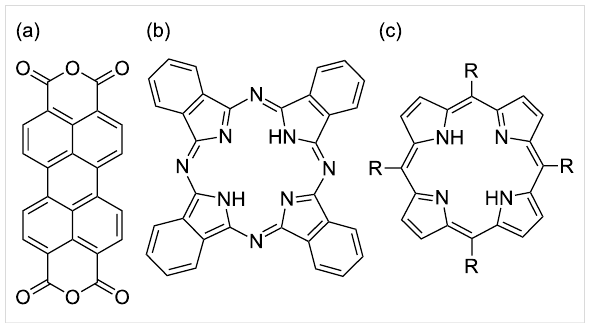
Figure 1: The discussed molecular species (a) PTCDA, (b) metal-free phthalocyanine (H 2 Pc), in which the central hydrogen atoms may be substituted by a metal atom, e.g., Cu, Co, Fe, giving rise to CuPc, CoPc, FePc, respectively, (c) porphyrin, in which the central hydrogen atoms may be substituted by a metal atom giving rise to metal porphy- rins; R stands for different